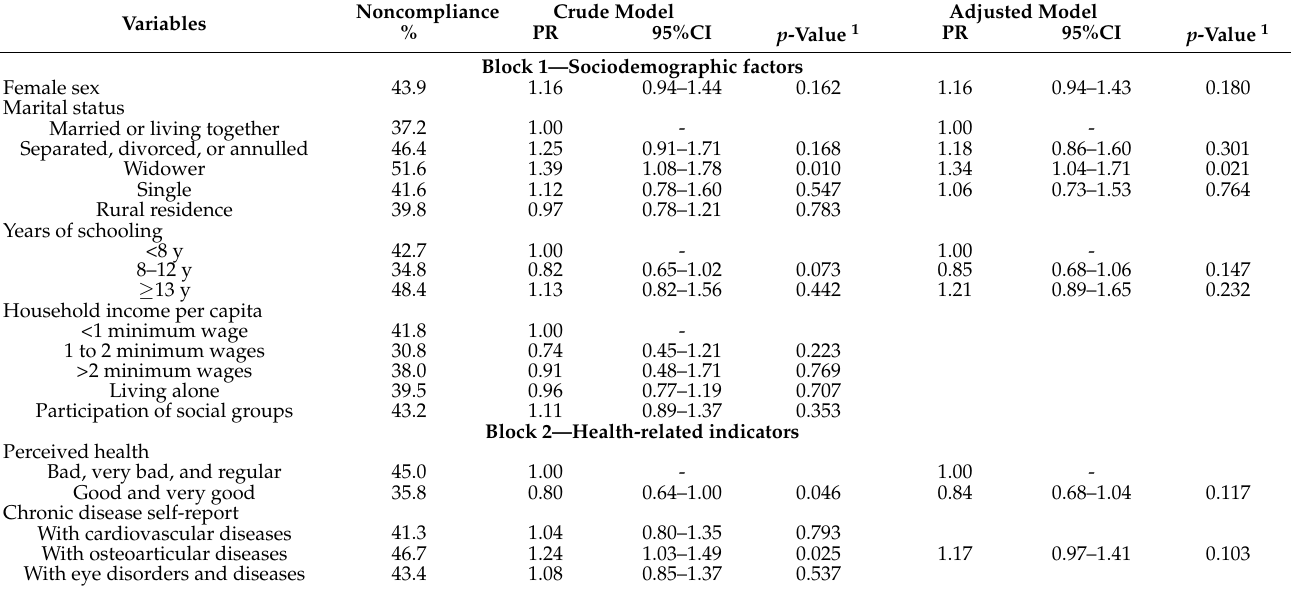
Table 3. Crude and hierarchically adjusted associated factors to food guideline compliance in elderly Chileans between 60 and 79